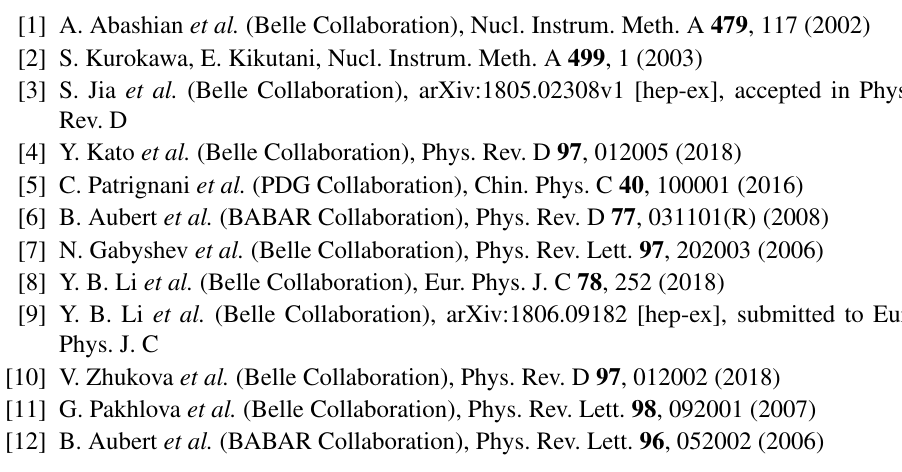
Figure 3: The exclusive cross sections as functions of D ( ∗ ) + D ( ∗ ) −